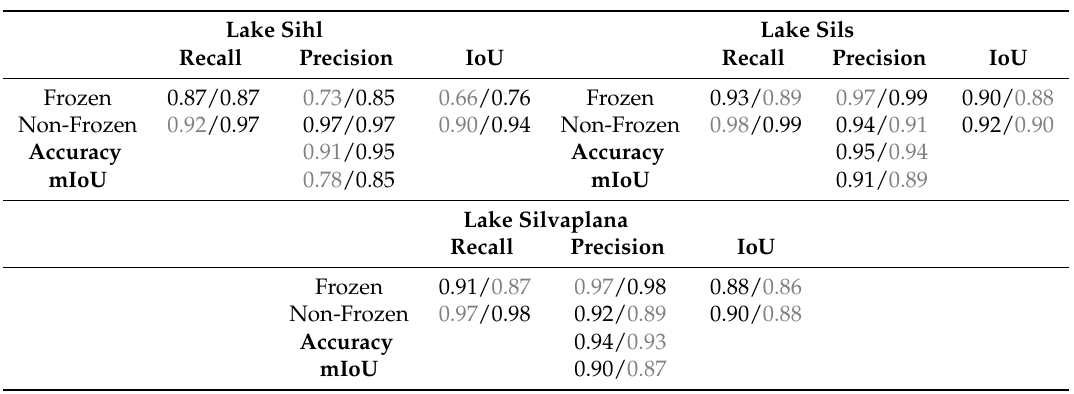
Table 10. VIIRS leave one lake out results. Numbers are in A/B format where A and B represent the results using RBF and linear kernels, respectively. The better kernel for a given experiment is shown in black, worse kernel in